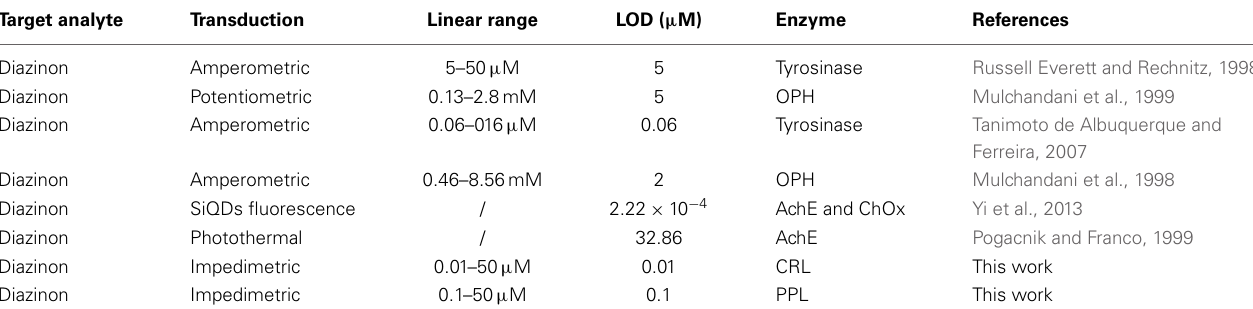
Table 2 | Analytical characteristics of enzymatic biosensors for the detection of diazinon.